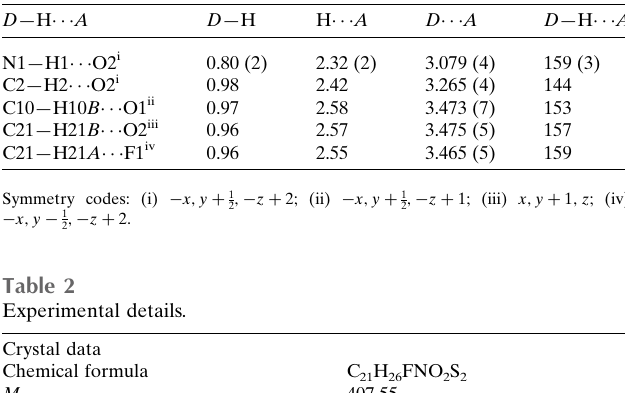
Table 1 Hydrogen-bond geometry (A˚ , (cid:3) ).